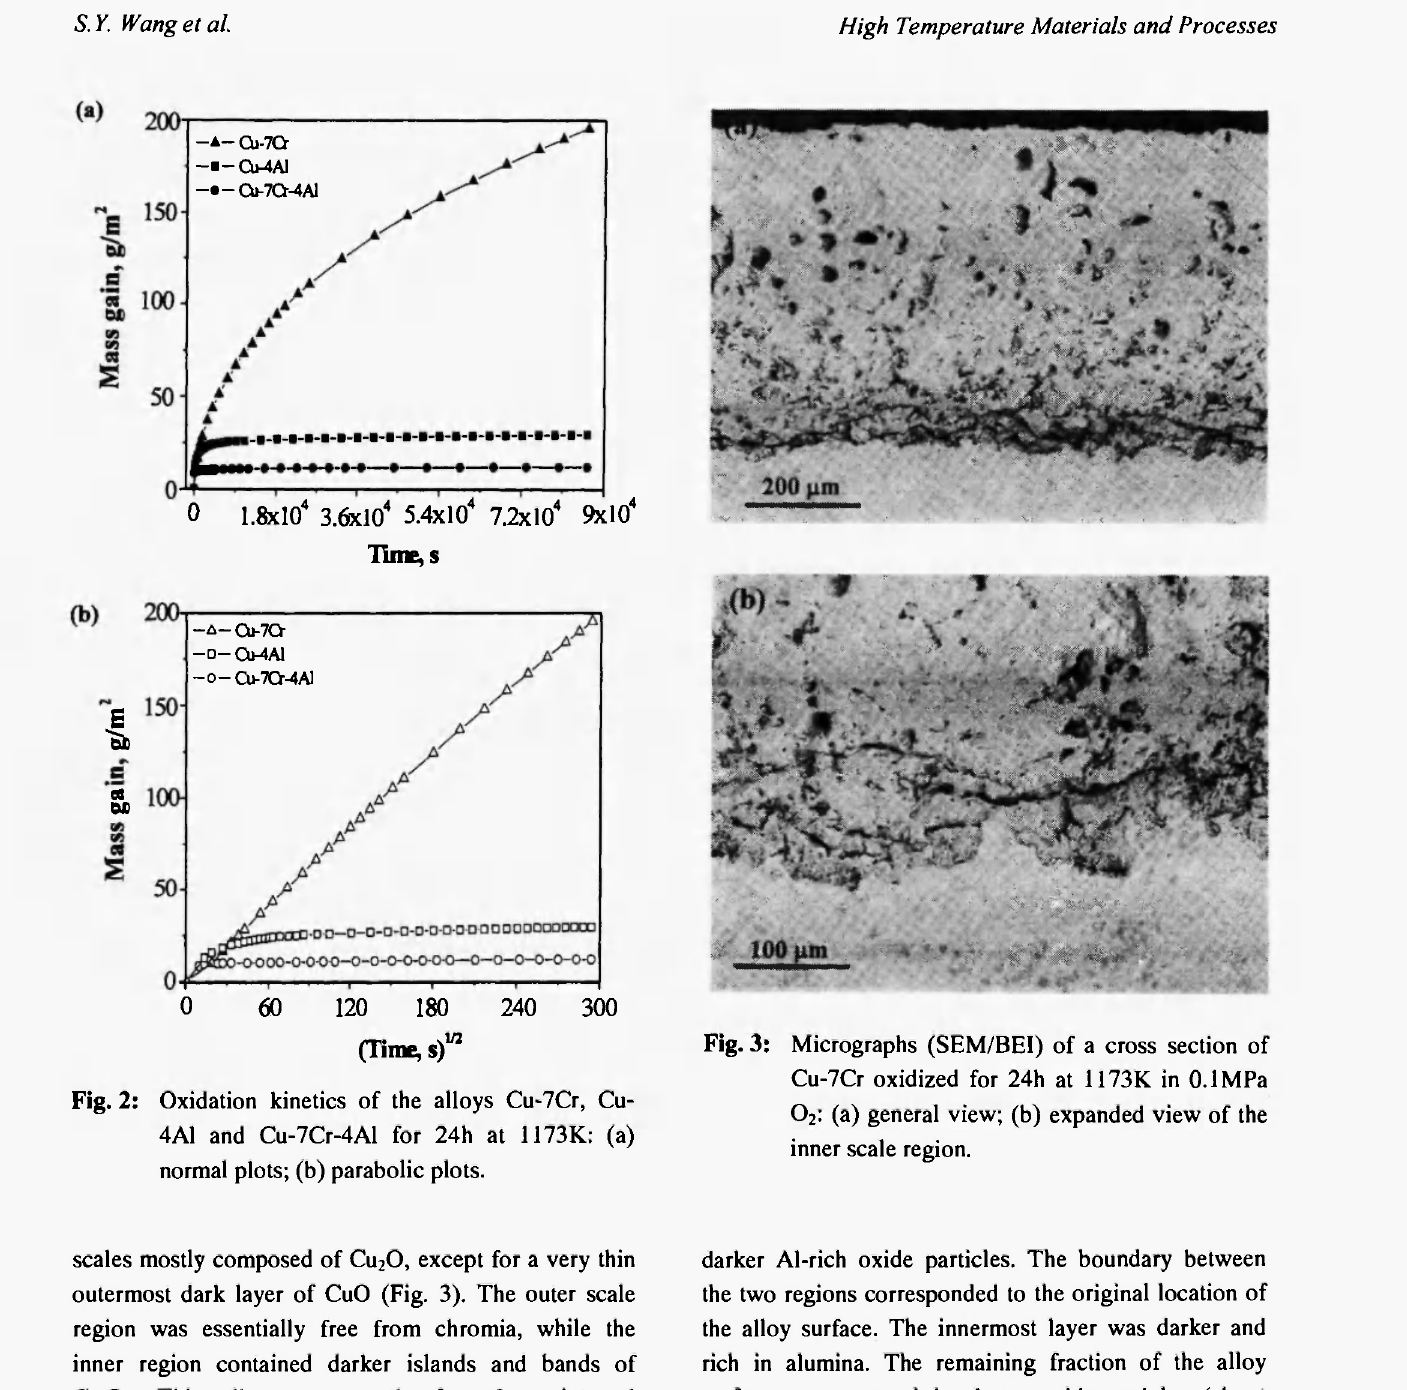
scales mostly composed of Cu 2 0, except for a very thin outermost dark layer of CuO (Fig. 3). The outer scale region was essentially free from chromia, while the inner region contained darker islands and bands of Cr 2 0 3 .